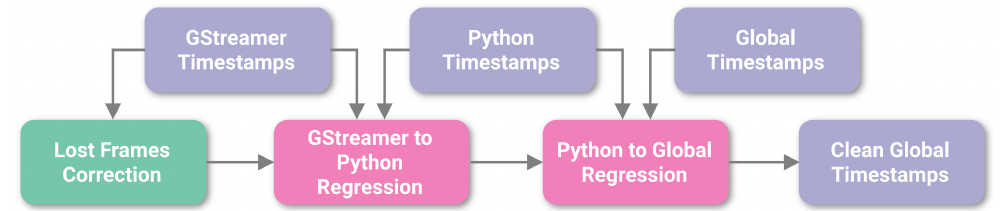
Figure 9. Diagram illustrating timestamp processing. We start with the least jittery GStreamer timestamps and identify any lost frames so that we can reconstruct the original timeline and average period for the saved frames. We then convert these reference timestamps into a global timeline through a series of regression steps that incorporate the information from other kinds of timestamps without adding jitter.